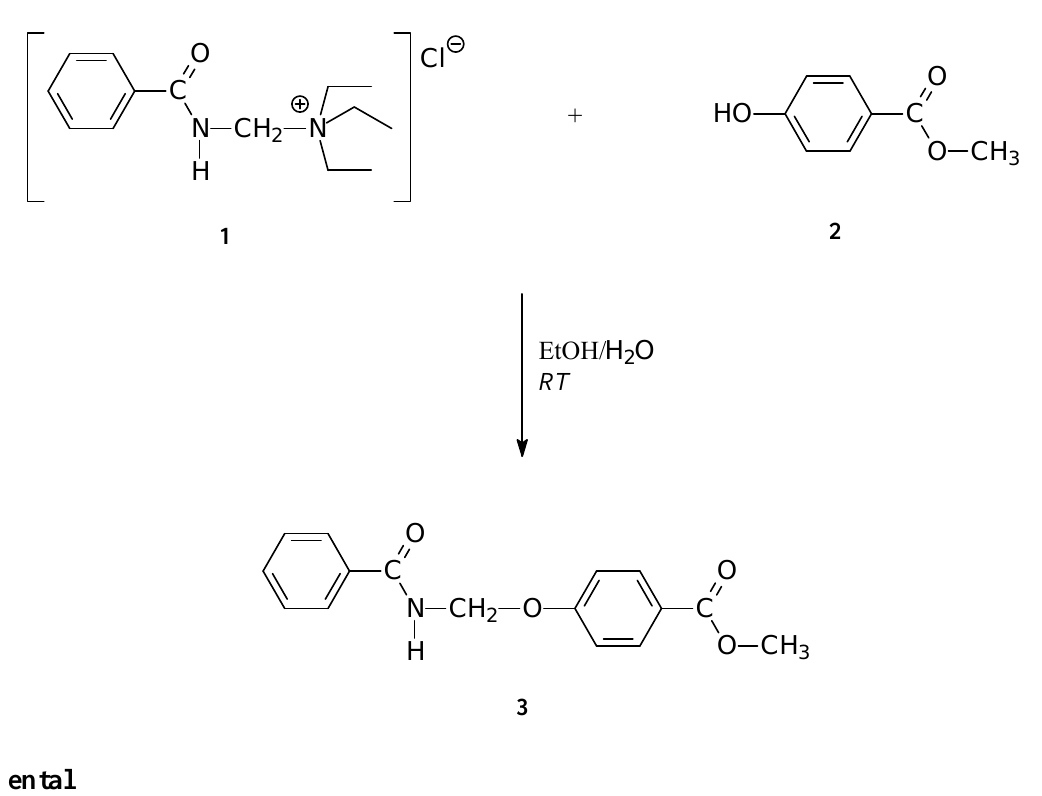
Scheme 1. Synthetic route to the title compound 3